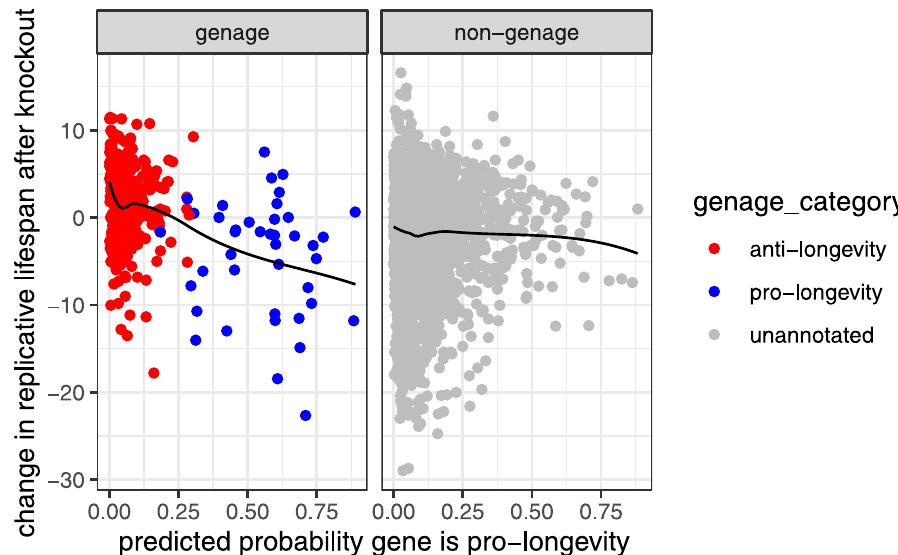
Fig 4. Predicted probability of a gene being pro-aging versus effect of deletion on replicative lifespan (RLS) in yeast. Probabilities are from the pglm classifier trained on the full GenAge dataset. Solid curve is a nonparametric